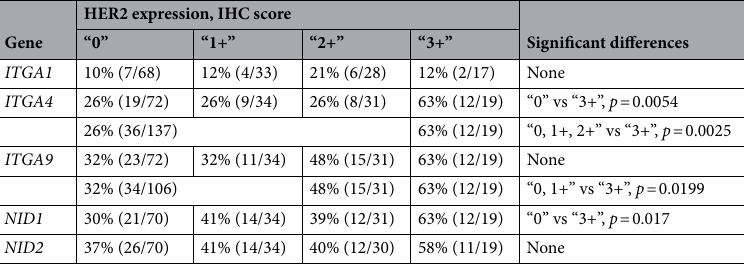
Table 2. Abnormal hypermethylation of CpG dinucleotides in the promoter regions of integrin and nidogen genes in breast cancer samples in relation to HER2 status.